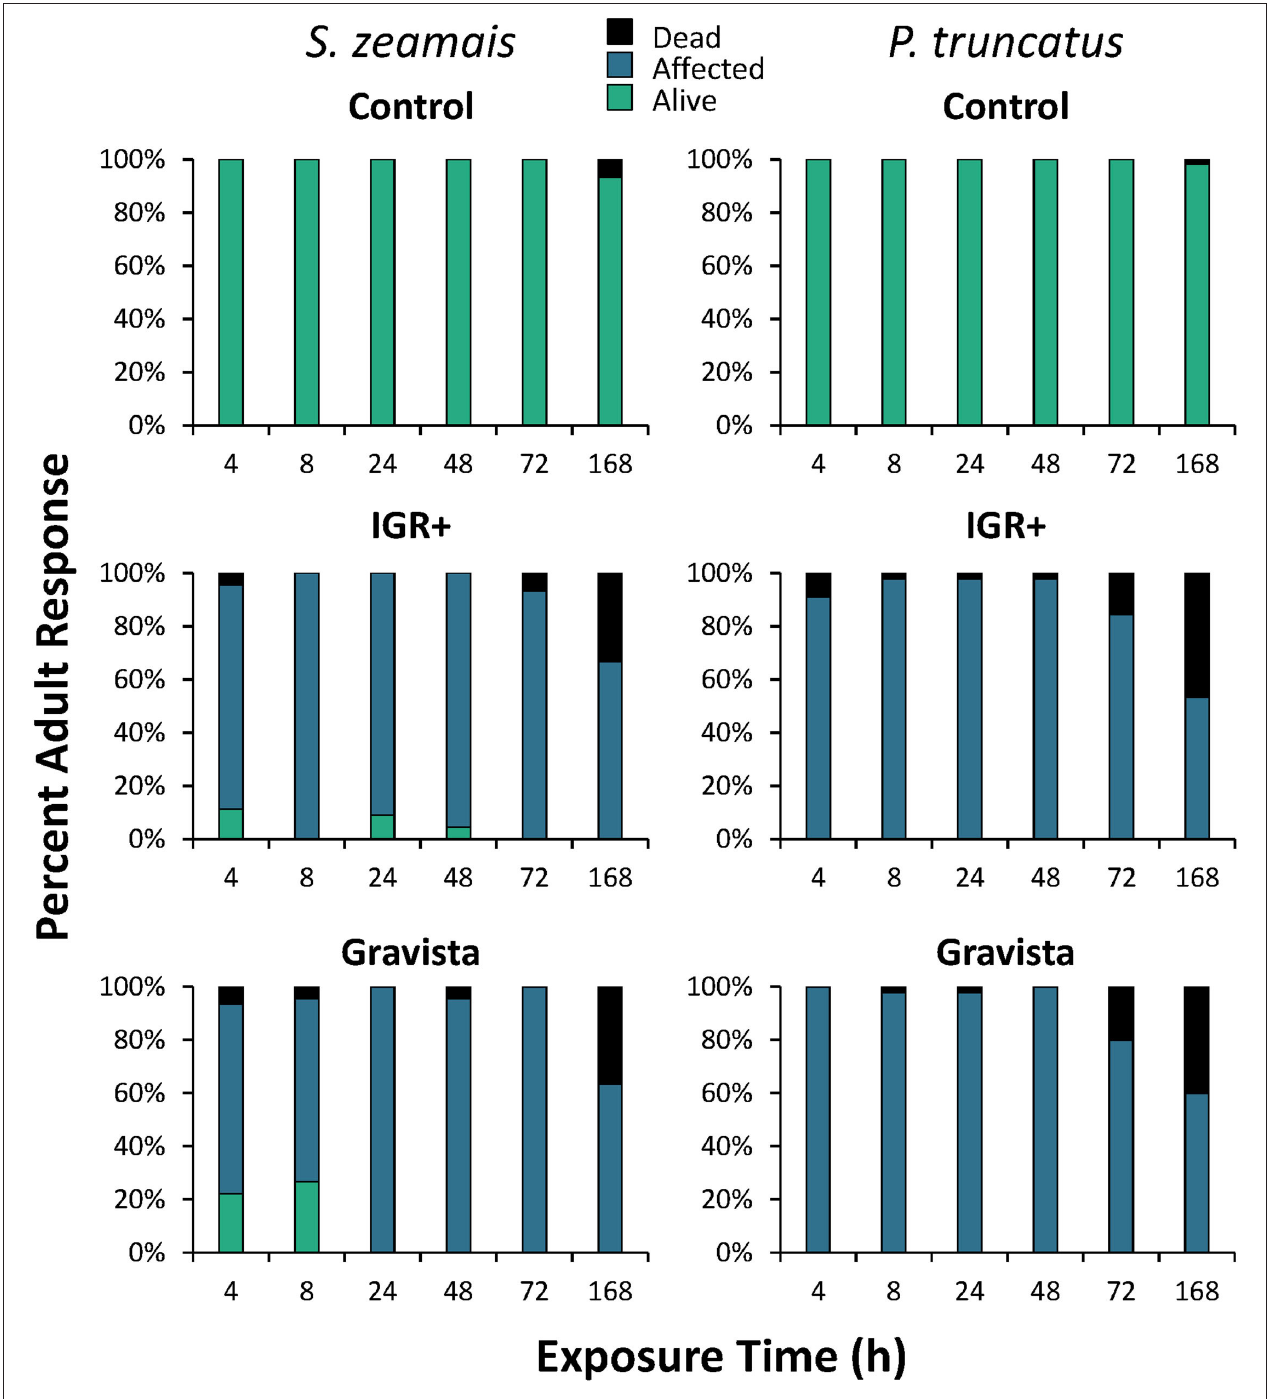
FIGURE 2 | Percent mortality induced by an existing (methoprene + deltamethrin, IGR + ) and novel (methoprene + deltamethrin + synergist, Gravista) commercial formulation of insecticide when applied against S. zeamais (left column) and P. truncatus (right column) on concrete arenas broken down by exposure time, resulting in alive (green), affected (blue), or dead (black) individuals.